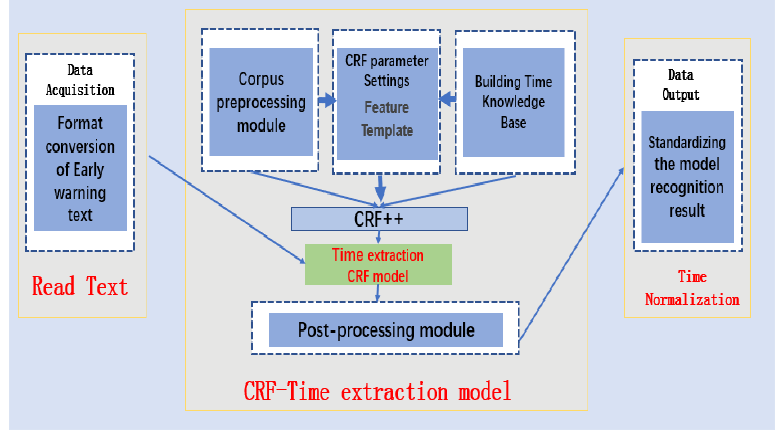
Fig. 2. Extraction process of early warning effective